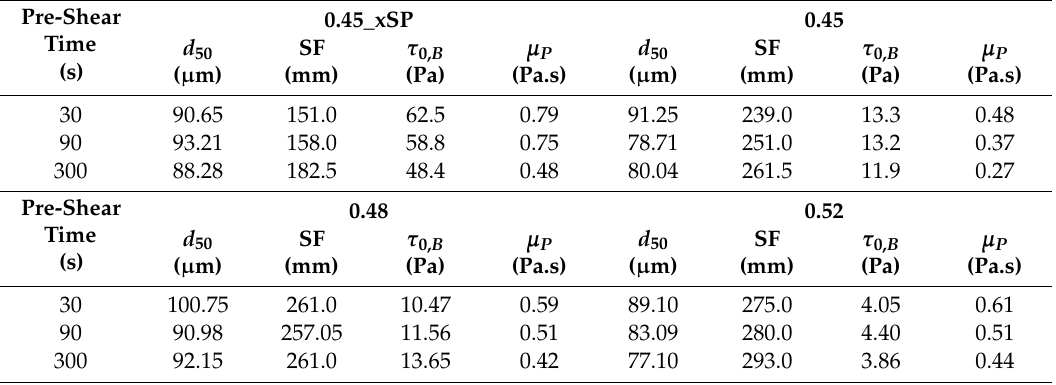
Table 2. Results of aggregate kinetics and rheological parameters for all testing series.